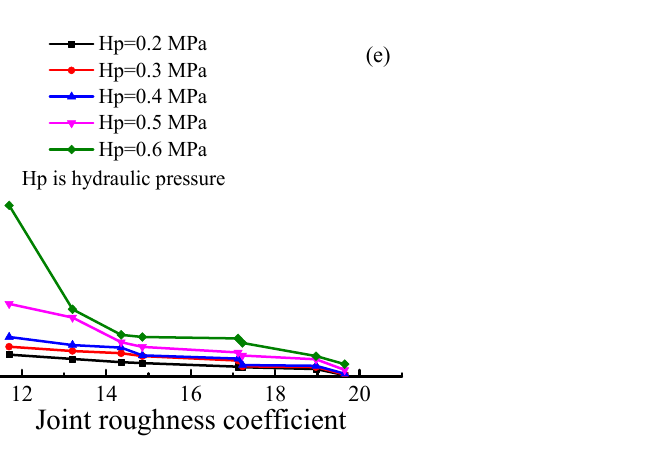
Figure 6. Relationship between joint roughness coefficient and seepage flow under different normal pressure and water pressure values. ( a ) Normal stress = 0.10 MPa, ( b ) Normal stress = 0.15 MPa, ( c ) Normal stress = 0.20 MPa, ( d ) Normal stress = 0.25 MPa, ( e ) Normal stress = 0.30 MPa, ( f ) Normal stress = 0.40 MPa.